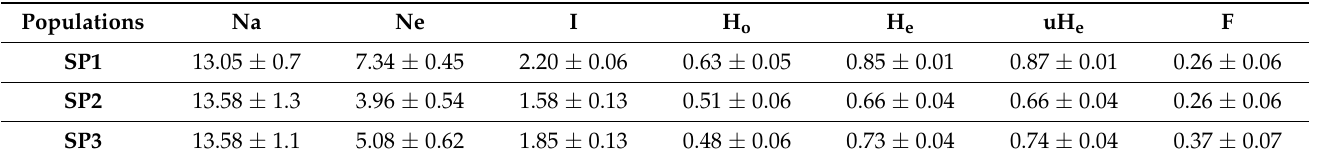
Table 3. Genetic diversity statistics of 163 Mithun, 10 gaur, and 25 Tho-tho cattle at subpopulation